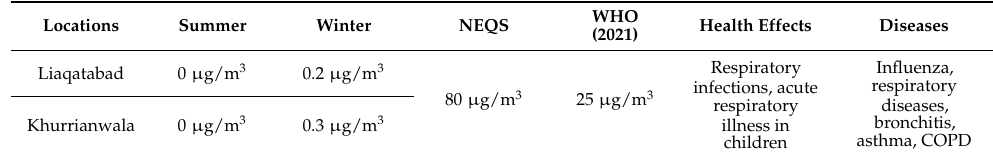
Table 2. Seasonal variation of NO 2 at selected sites in comparison of NEQS and WHO and corre- sponding health